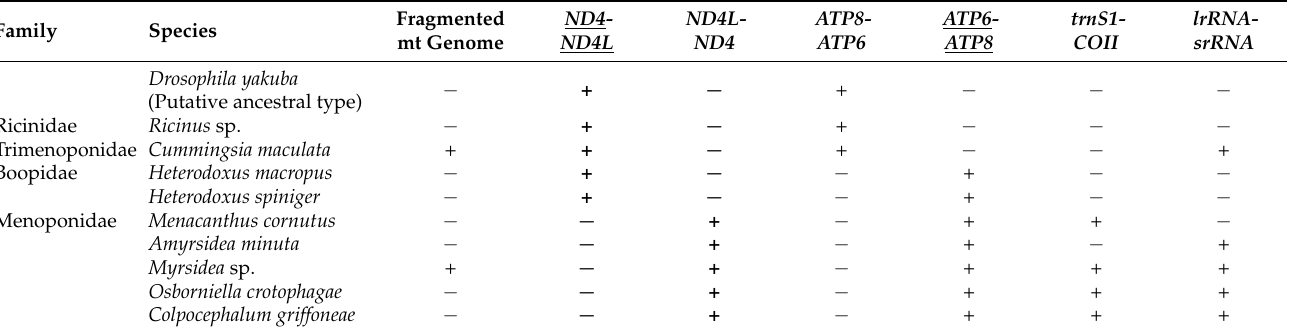
Table 2. The derived mitochondrial gene blocks shared by parasitic lice in